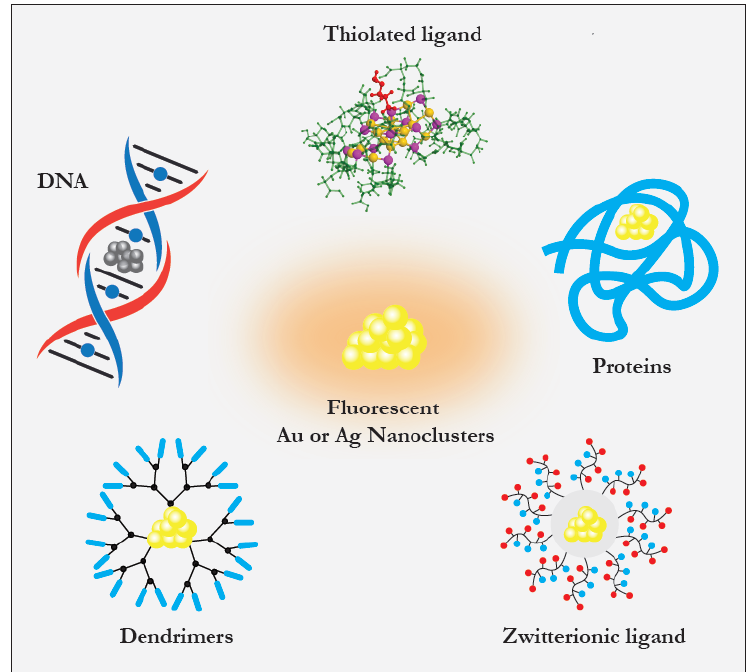
Figure 2. Metal nanoclusters protected with different scaffolds